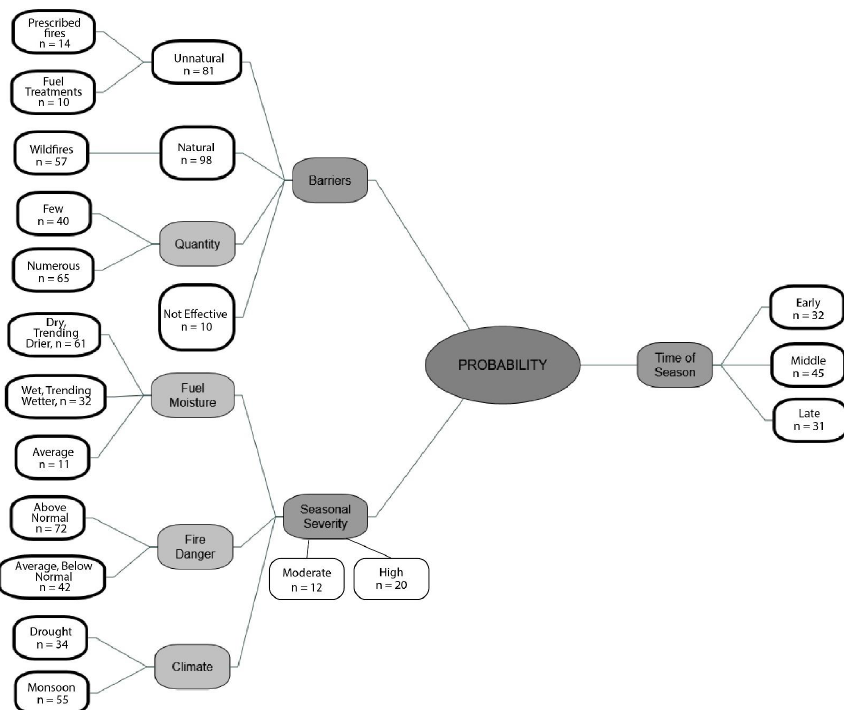
Figure A2. The Probability Element is summarized by themes (Time of Season, Seasonal Severity and Barriers). The themes are further described by second and third-order sub-themes (light grey shapes), used to summarize types of codes, with the total number of wildfires associated with a specific code, denoted with white shapes.